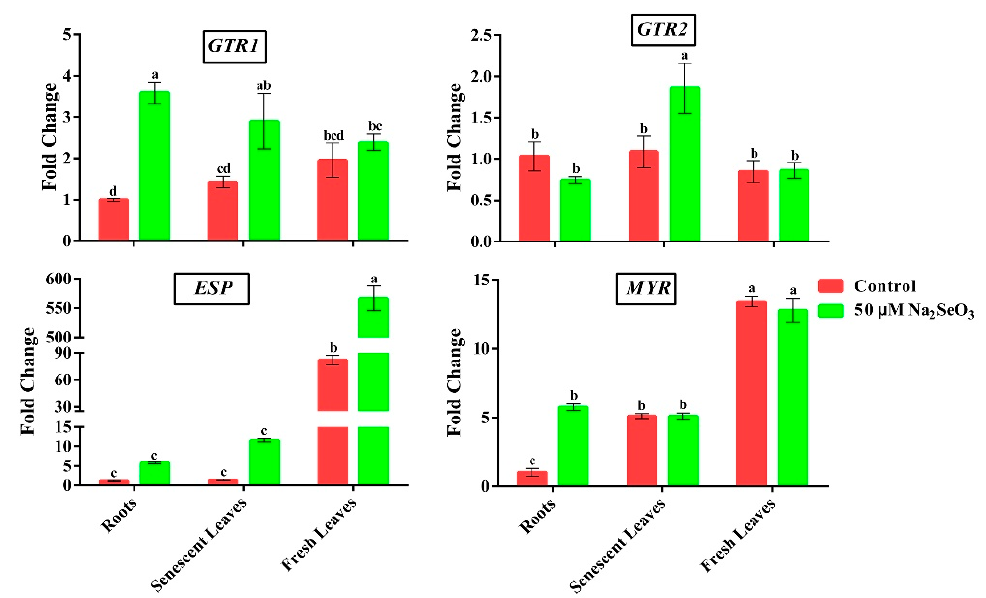
Figure 6. Effect of Se on the genes expressions related to GSLs transport and 4MSOB degradation. Different letters indicate significant differences compared to roots under control.